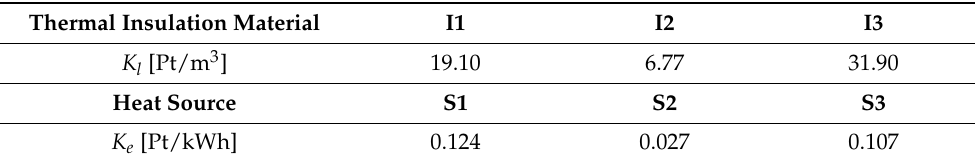
Table 3. Results of LCA